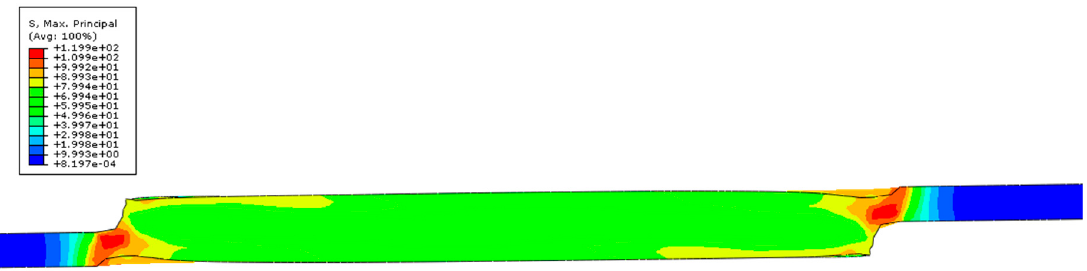
Figure 14. Maximum principal stress—local concentration on the joint end.